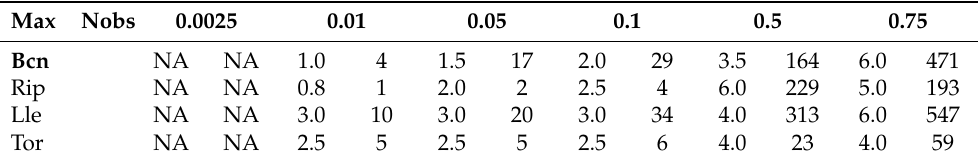
Figure 5. As in Figure 4 but for the maximum hail diameter registered from ground observations. Table 2. Maximum diameter of hail and total number of hail cases (of any size) per pixel depending on the resolution for the four cities considered in the previous section.